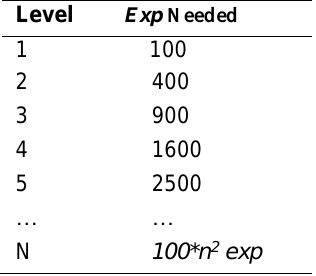
Table 1. Polynomial Method for Level Progression